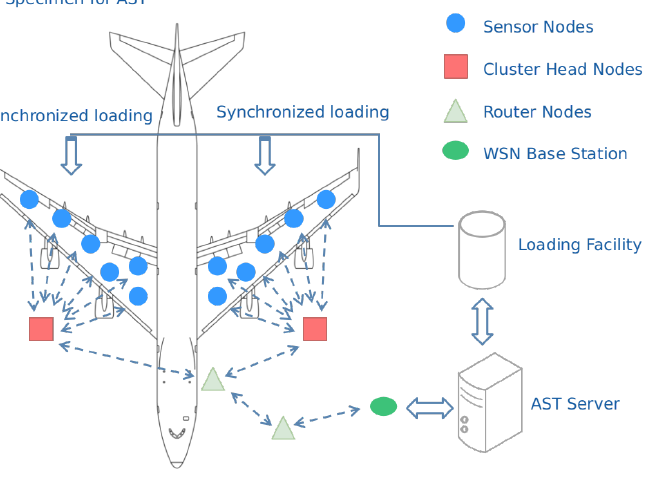
Figure 1. The AST–WSN topology comprises cluster head nodes that forward data to the router nodes, which finally sends the sensed information to an AST Server for storage and